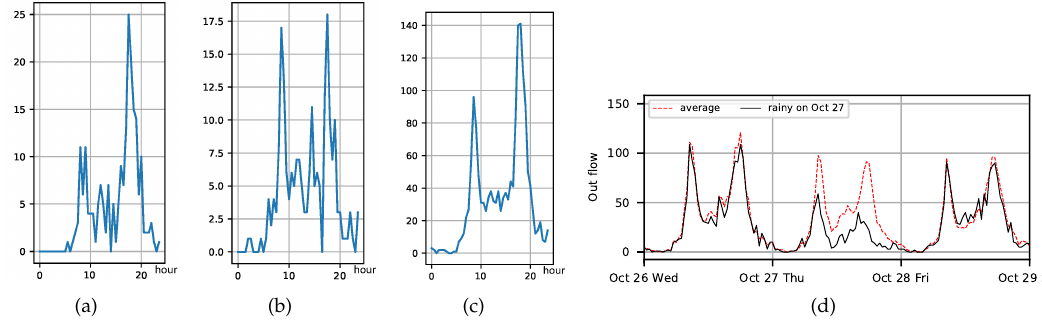
Figure 3. ( a , b ) The variation in out-flow count of two stations in one day. ( c ) The variation in out-flow count of a region with seven stations in one day. ( d ) The effect of weather on the fluctuation of crowd flow (27 October, 2016 in New York City was a rainy